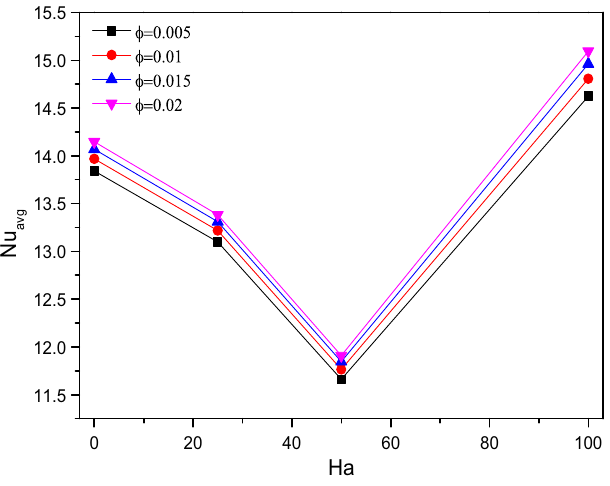
Figure 12. Variations of Nu avg with various Ha for ϕ variations, Re = 1000 , Ri = 1